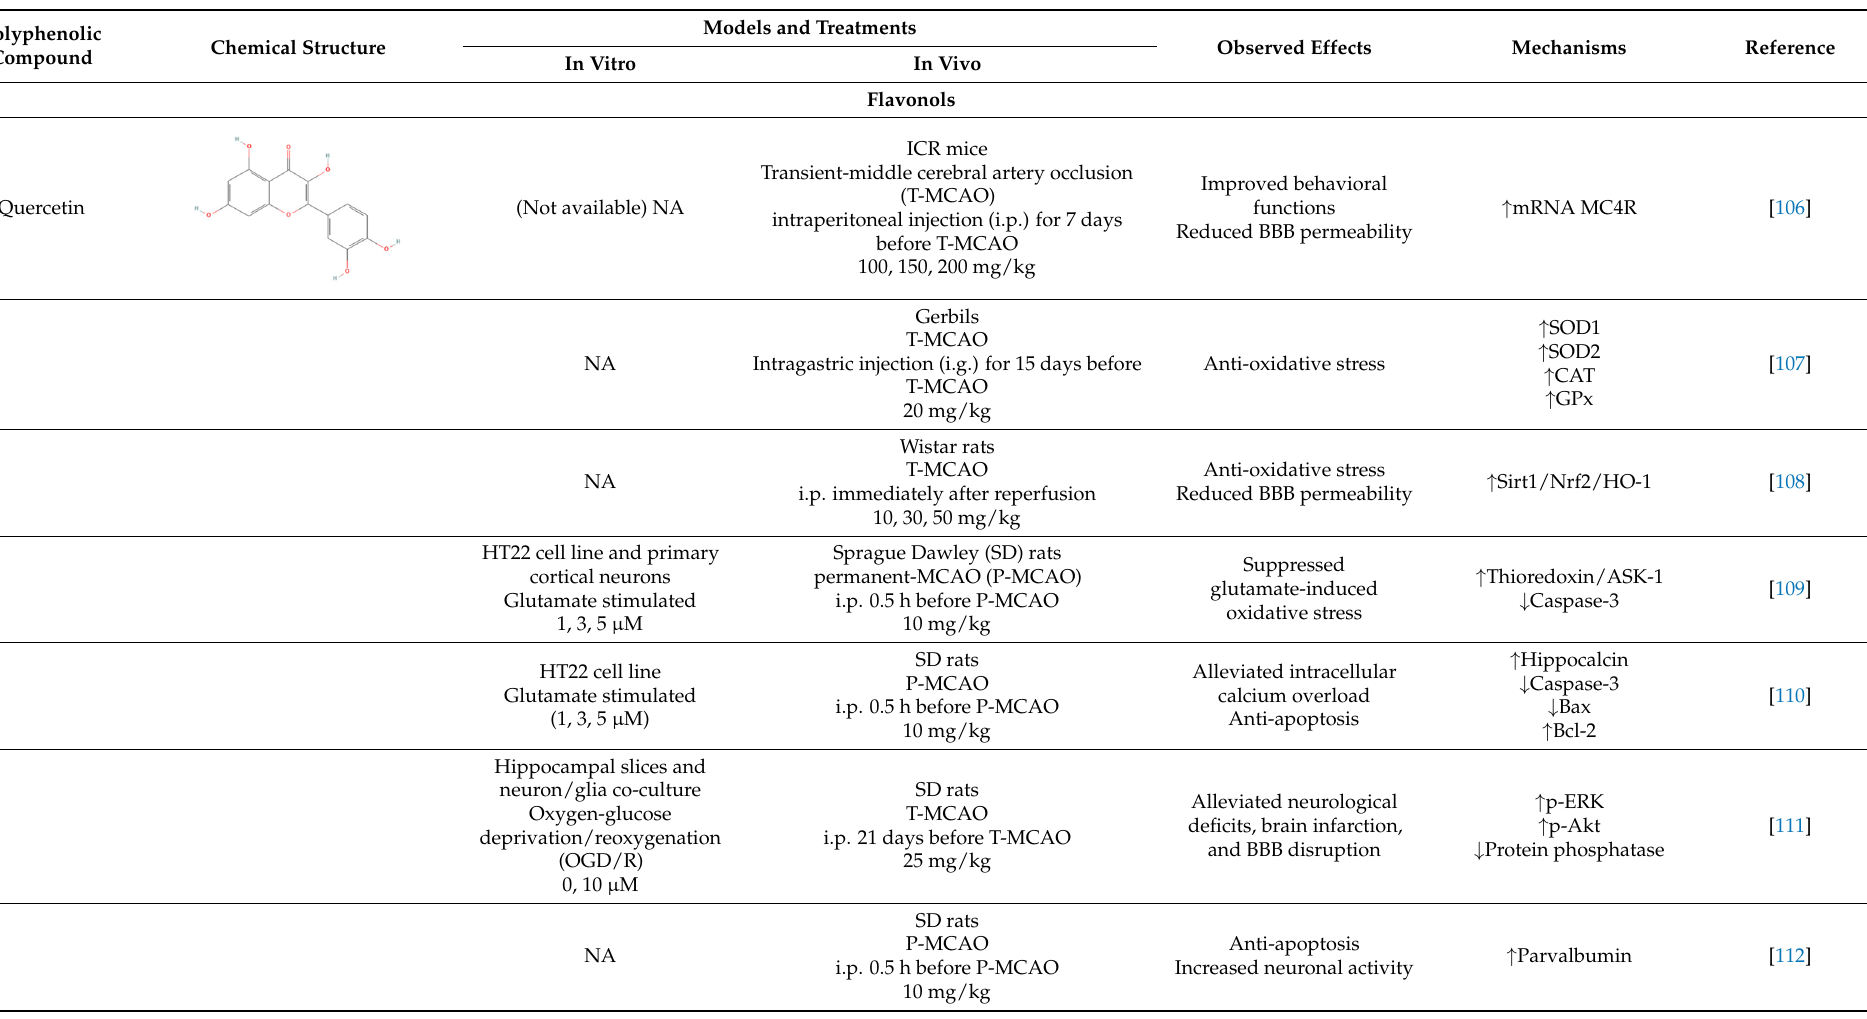
Table 1. Summary of studies on the anti-IS effects of flavonoids.